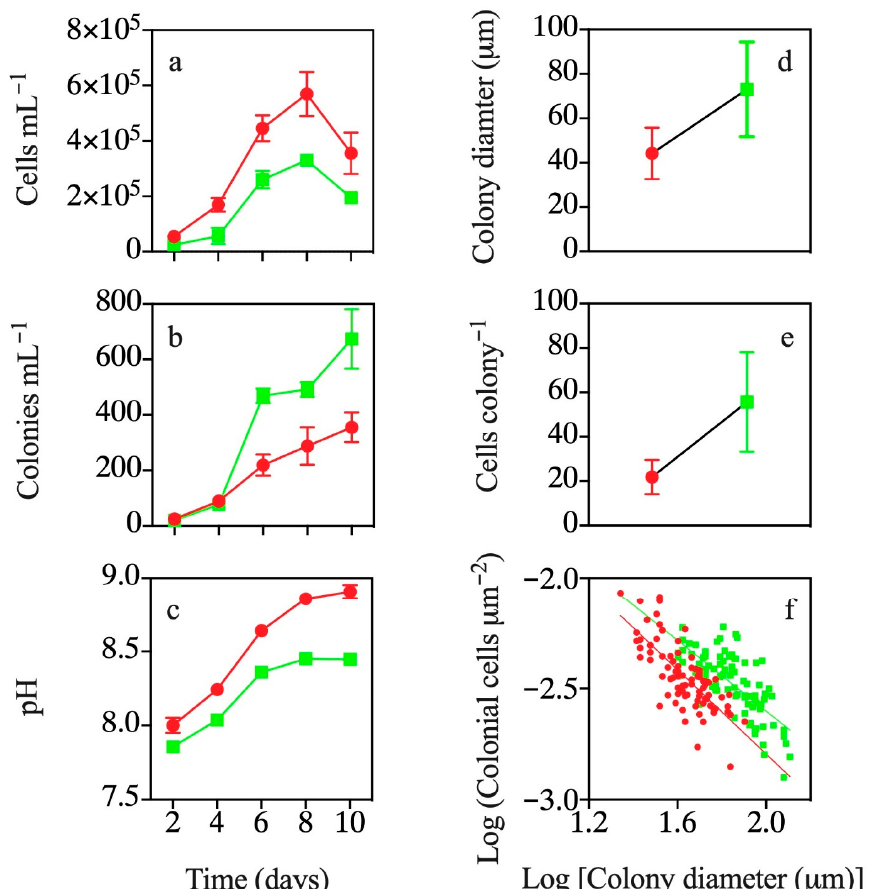
Figure 2. ( a ) The solitary cell abundances (Mean ± SD, n = 3), ( b ) the number of colonies (Mean ± SD, n = 3), ( c ) pH (Mean ± SD, n = 3), ( d ) colony diameters (Mean ± SD, n = 90), ( e ) the number of cells per colony (Mean ± SD, n = 90) and ( f ) linear relationship between Log (colonial cells µm − 2 ) and Log [colony diameter (µm)] (n = 90 for control and treatment) in P. globosa grown alone (red circles) and exposed to cell-free filtrates of T. weissflogii (green squares).